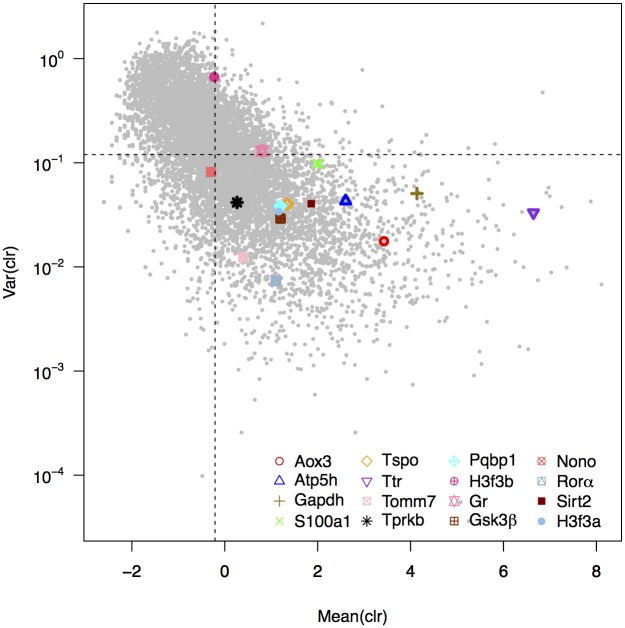
Analysis of the variance of expression of the candidate genes using RNA-sequencing data.For each gene was calculated the variance and mean across four experimental conditions (3, 9, 15 and 21 month-old mice) of the centered log-ratio (clr) of their expression (grey dots). The 16 candidate genes are highlighted and the median variance clr and median mean clr across all genes are shown as dashed lines.